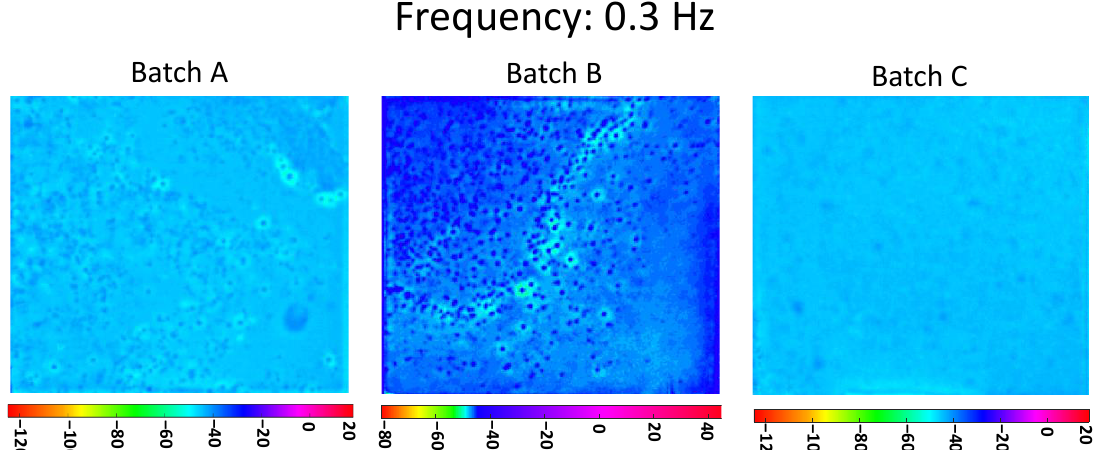
Figure 4. Pulsed phase thermography (PPT) phasegrams of a sample of each batch computed at the